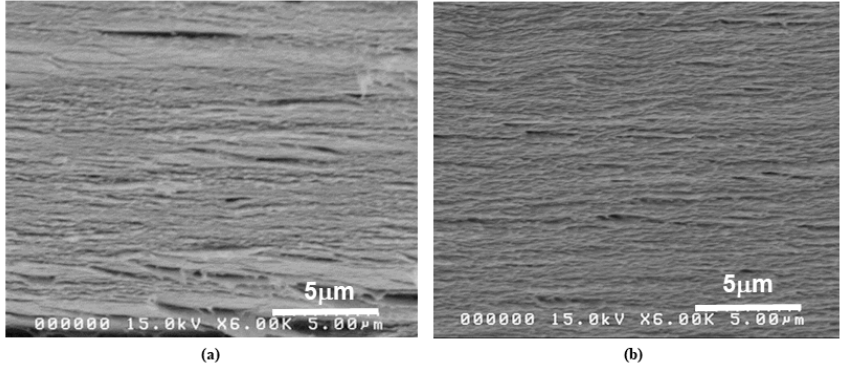
Figure 3. Cross-sectional SEM images: ( a ) PCC0 hydrogel; ( b ) PCC3 hydrogel.